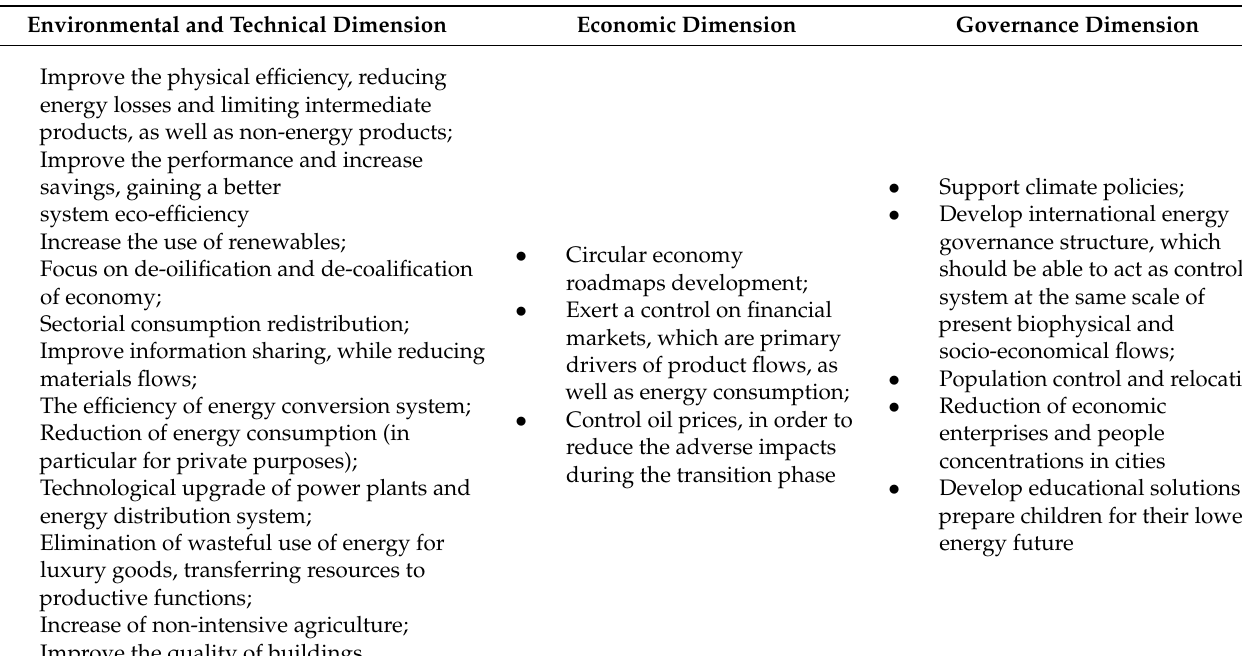
Table 10. Multi-dimensional (environmental/technical; economic; governance) energy policy options with respect to identified challenges and SDGs. Behind this study, different references are used to compile this table. They refer to: (i) Environmental and Technical solutions; (ii) Economic dimension; (iii) Governance